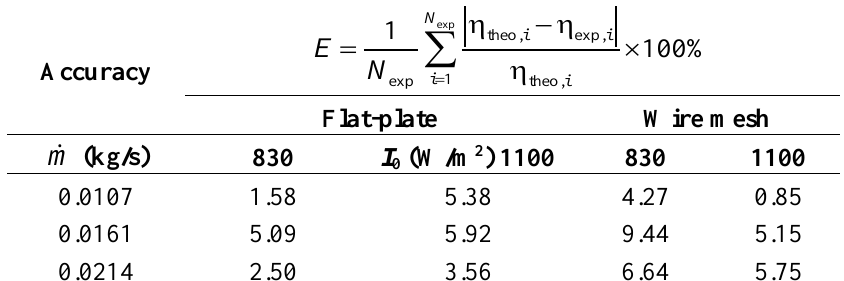
Table 3. The deviation of the experimental results from theoretical predictions both in flat-plate type and wire mesh